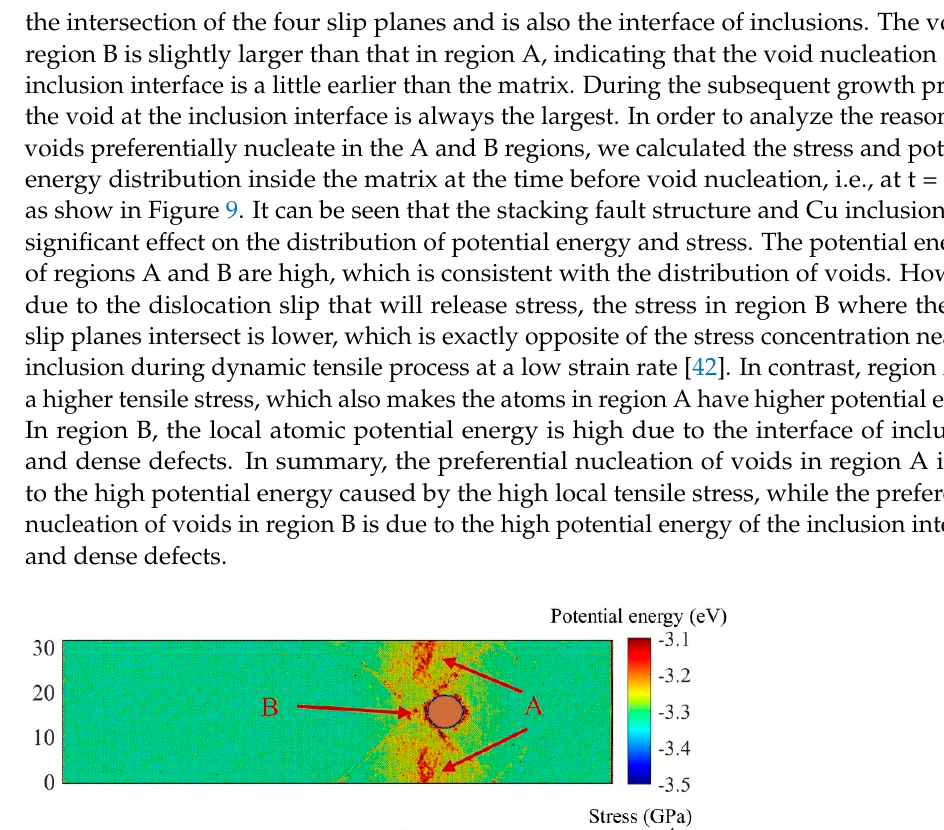
Figure 9. Spatial distributions of longitudinal stress components and atomic potential energy in the Al matrix in the central section of the system, u p = 0.8 km/s, t = 26 ps. Regions A and B here correspond to regions A and B in Figure 8a.